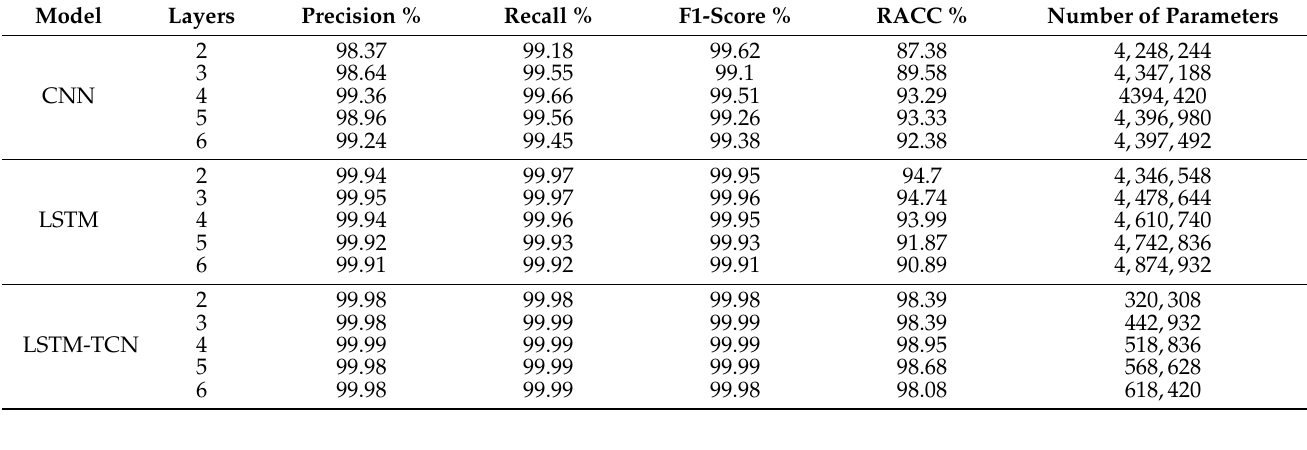
Table 4. Performance evaluation of the IEEE 118-bus power system under L 2 -norm = 2.